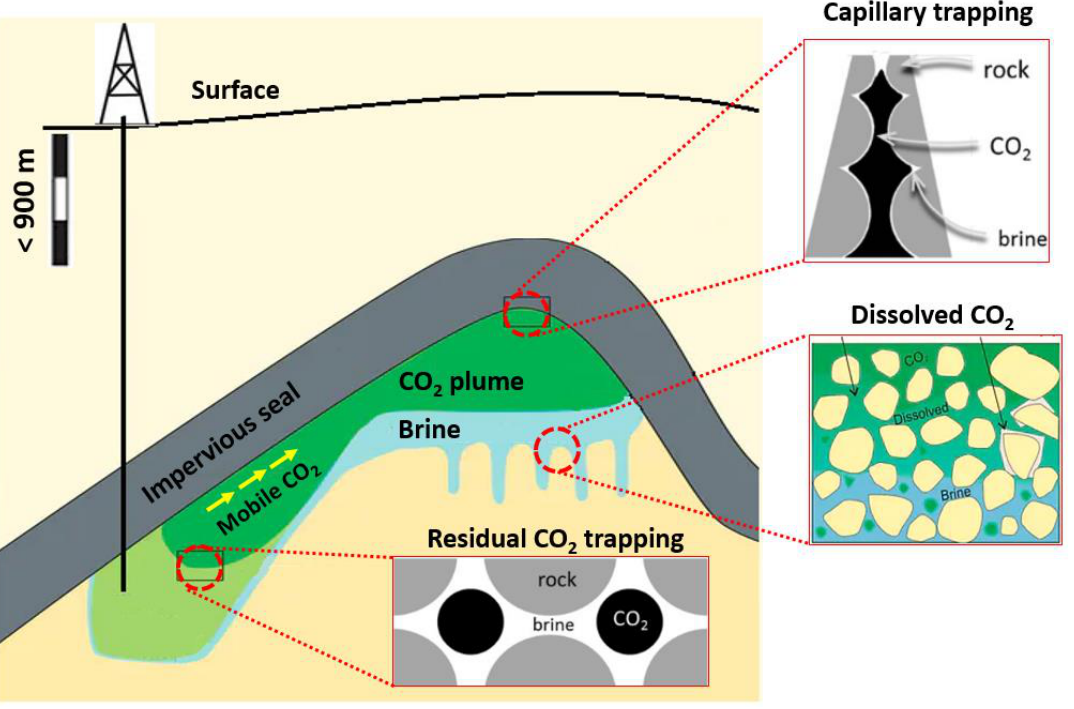
Figure 1. Illustration of the trapping mechanism in pore-scale for a water-wet condition. Reprinted/adapted with permission from Ref. [20] 2022 Elsevier.